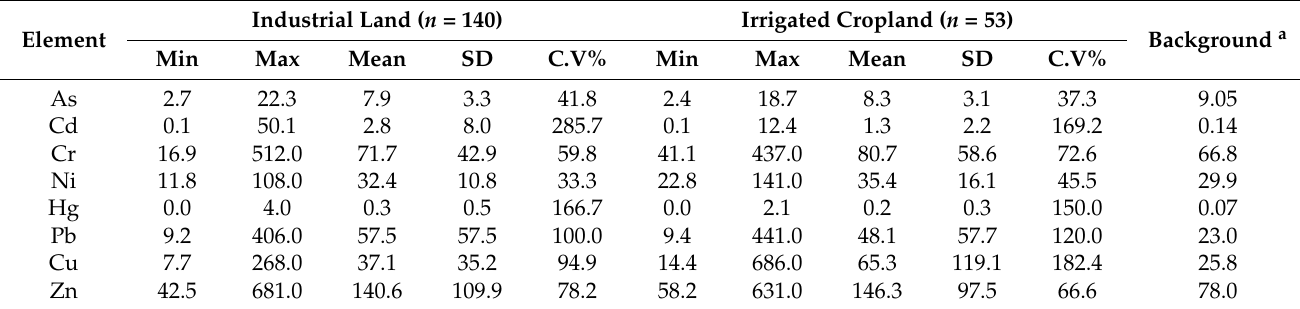
Table 5. Statistical results of heavy metal concentrations in soil